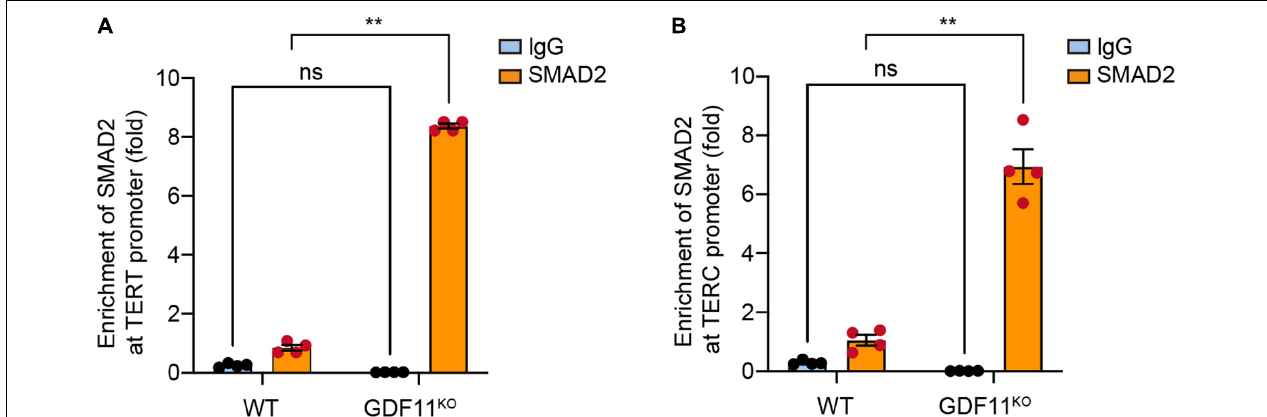
FIGURE 4 | Loss of GDF11 enhances SMAD2 binding to the promoters of TERT and TERC. CHIP-qPCR assessment of the enrichment of SMAD2 at the promoters of TERT (A) (two-way ANOVA, interaction: F ( 1 , 12 ) = 3,595, p < 0.001; WT vs. GDF11 KO : F ( 1 , 12 ) = 3,176 , p < 0.001; IgG vs. SMAD2: F ( 1 , 12 ) = 4,788, p < 0.001; Sidak’s test, SMAD2: WT vs. GDF11 KO , p < 0.001; four samples per group ) and TERC (B) (two-way ANOVA, interaction: F ( 1 , 12 ) = 101, p < 0.001; WT vs. GDF11 KO : F ( 1 , 12 ) = 83.6, p < 0.001; IgG vs. SMAD2: F ( 1 , 12 ) = 157, p < 0.001; Sidak’s test, SMAD2: WT vs. GDF11 KO , p < 0.001; four samples per group) in the single clone-derived GDF11 KO and WT Neuro 2a cells that were cultured for 40 days. Data are represented as mean ± SEM, ** p <